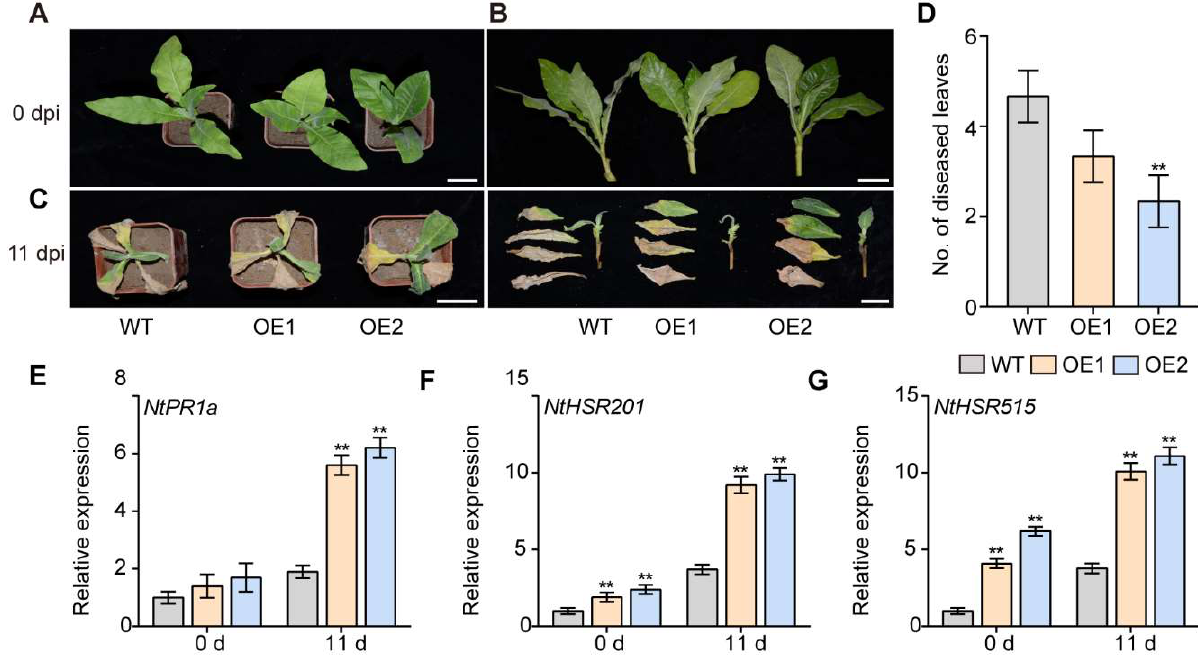
Figure 11. Development of plant disease symptoms in WT and IbPIF3.2 -OE transgenic tobacco plants after Fob inoculation. W38 and IbPIF3.1 -OE transgenic plants were inoculated with Fob spores at a density of 1.5 × 10 7 mL −1 for 11 d: ( A , B ) phenotypes; ( C ) development of disease symptoms in leaves of WT and IbPIF3.1 -OE transgenic tobacco lines after Fob inoculation (scale bar = 2.5 cm); ( D ) the number of diseased leaves in WT and IbPIF3.1 -OE transgenic tobacco lines at 11 d; and transcript levels of ( E ) NtPR1a ; ( F ) NtHSR201 ; and ( G ) NtHSR515 in WT and IbPIF3.1 -OE transgenic tobacco lines. The transcript levels of genes in WT before inoculation were set to 1. The values were determined by qRT-PCR from three biological replicates consisting of pools of three leaves. The error bars indicate ± SD ( n = 3). **, p < 0.01; Student’s t –test.